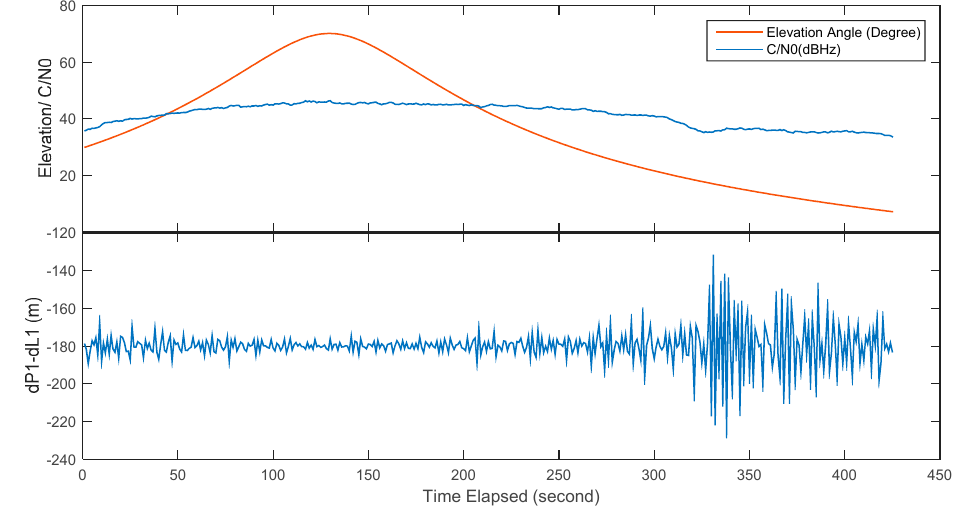
Figure 10. The pseudorange noise of Luojia-1A H1 signal.